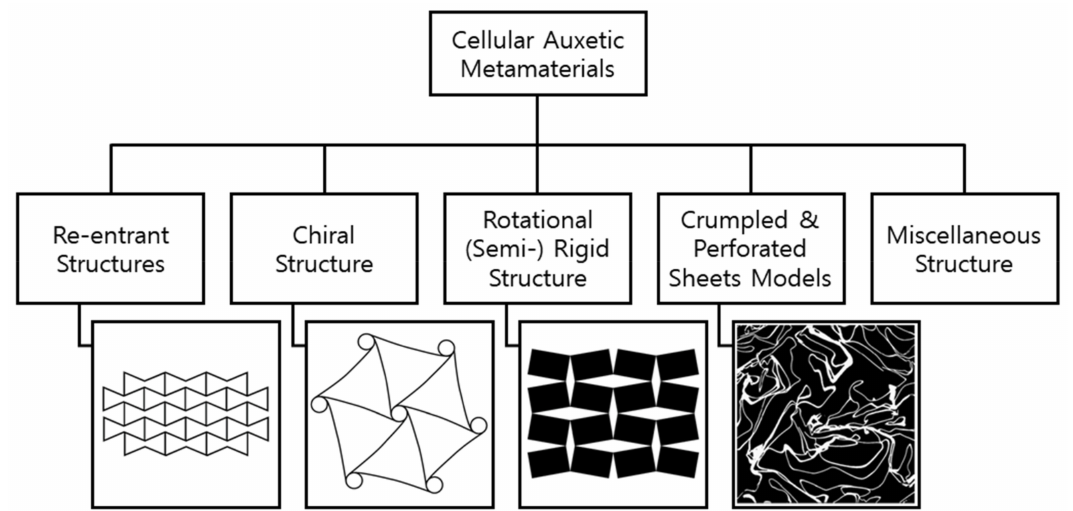
Figure 5. Classification of cellular auxetic metamaterials. Adapted from [21].